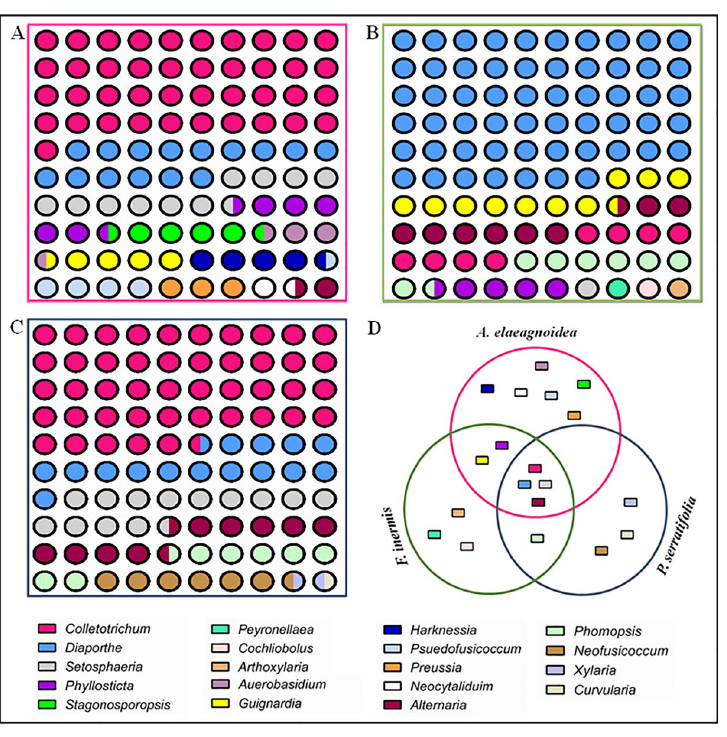
Fig 11. Relative percentage occurrence of different foliar endophytic fungal taxa isolated from (A) A . elaeagniodea , (B) F . inermis and (C) P . serratifolia and (D) Illustration of the host specificity.